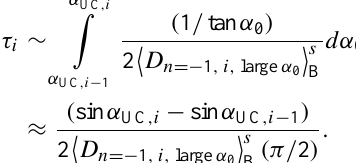
Fig. 5. Schematic representation of the cyclotron and Landau dif- fusion coefficients for waves i = 1 (hiss, solid black line) and i = 2 (lightning-generated, solid blue line) at L < 3 . 5, as a function of equatorial pitch angle. The corresponding approximate analytical diffusion coefficients are also displayed (dotted